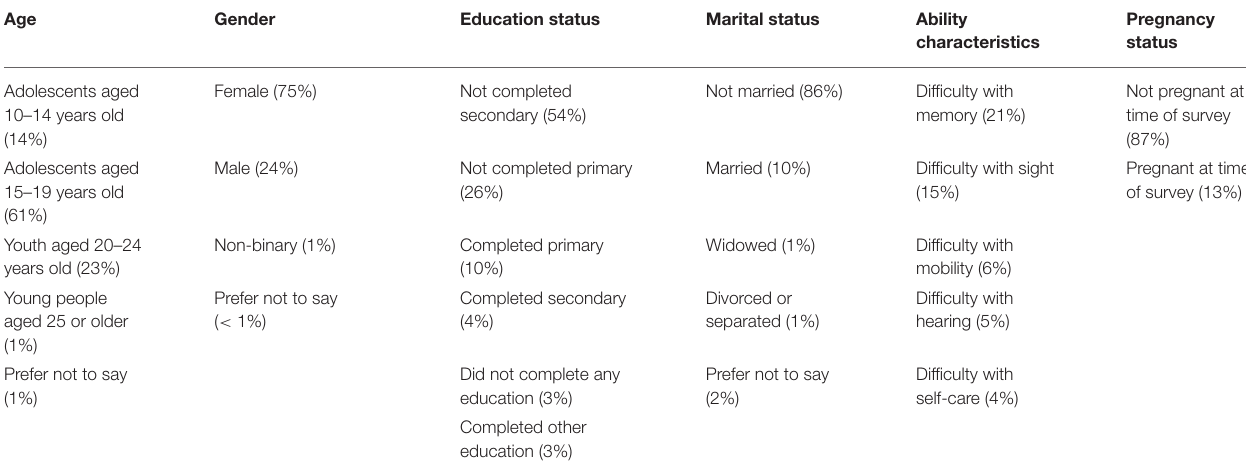
TABLE 1 | Study population and